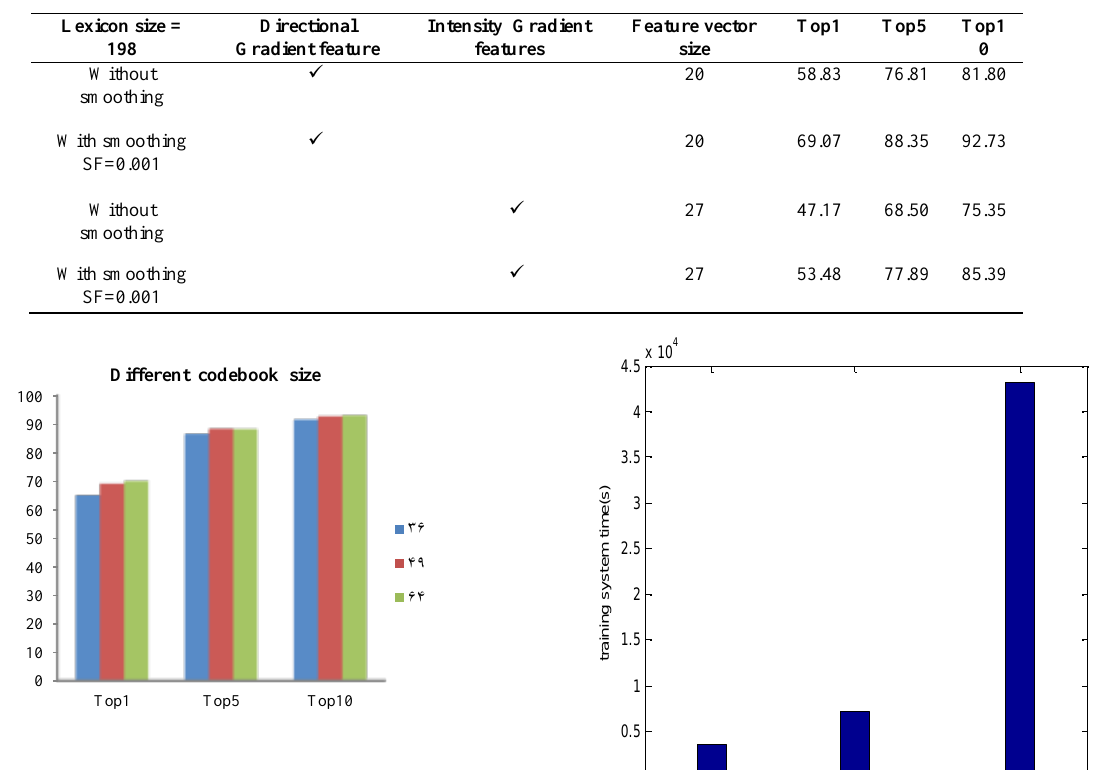
Figure7. Comparison of recognition results with different codebook size.